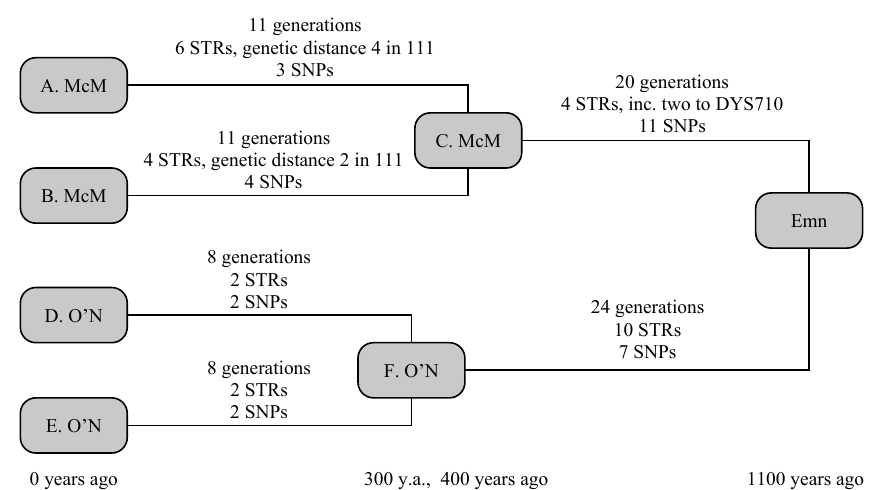
Figure 2. A schematic representation of the example given in Section 3.2.